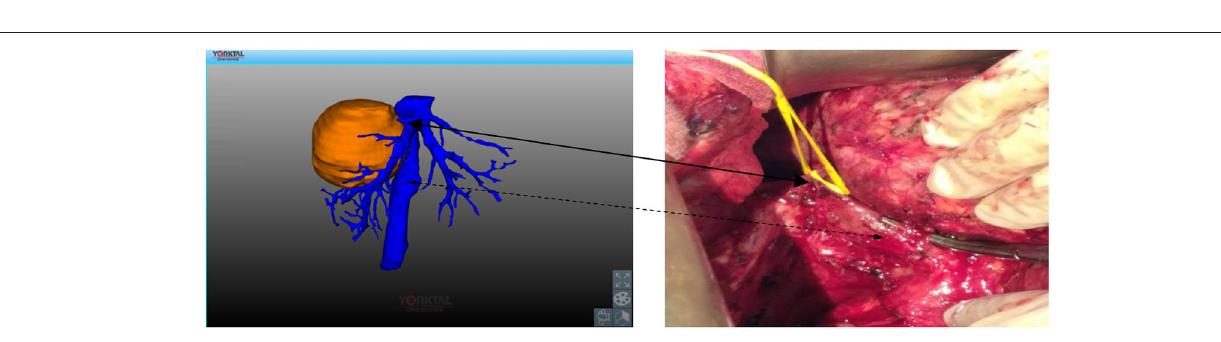
FIGURE 2 | Invasion of the V segmental branch of the portal vein by hydatid. Solid line arrow: V segmental branch of the portal vein.